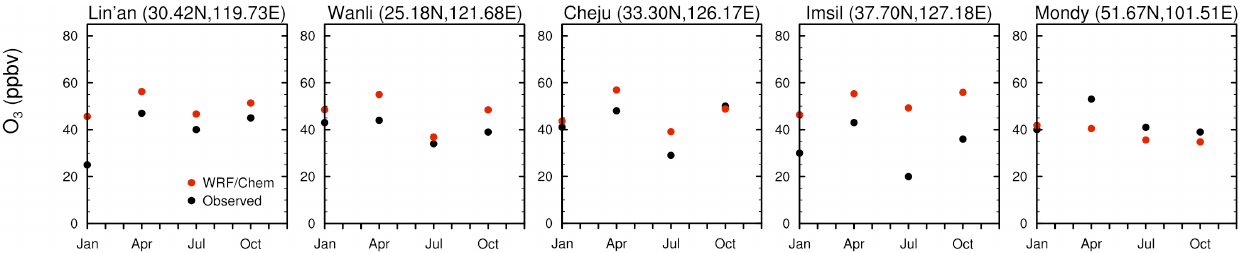
Fig. 5. Comparison of observed (black) and simulated (red) monthly mean 12-h daily average (08:00a.m.–08:00p.m.) O 3 mixing ratios (ppbv) at Lin’an (China), comparison of observed and simulated monthly mean 24-h daily average mixing ratios (ppbv) at Wanli (China), Cheju (Korea), Imsil (Korea), and Mondy (Russia). Observed values from Lin’an were taken from Wang and Mauzerall (2004). The observations for Lin’an were made between August 1999 and July 2000. Observed values from Wanli were taken from Chou et al. (2006). Observed values from Cheju, Imsil, and Mondy are taken from EANET data for 2002.